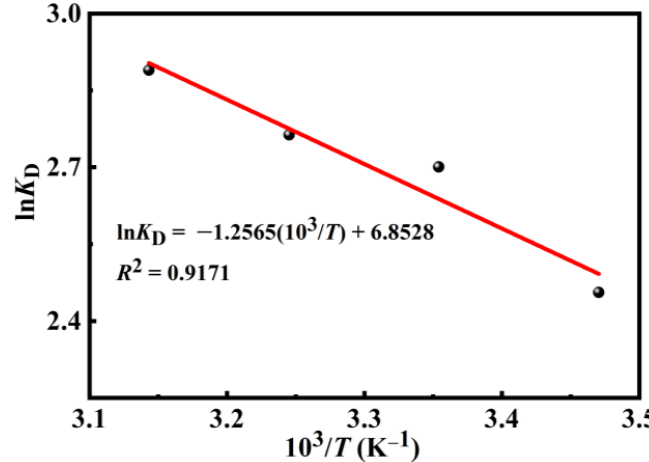
Figure 10. The linear relationship between ln K D and 10 3 / T . Table 4. Thermodynamic factors of defluoridation by LMF11 NFs.